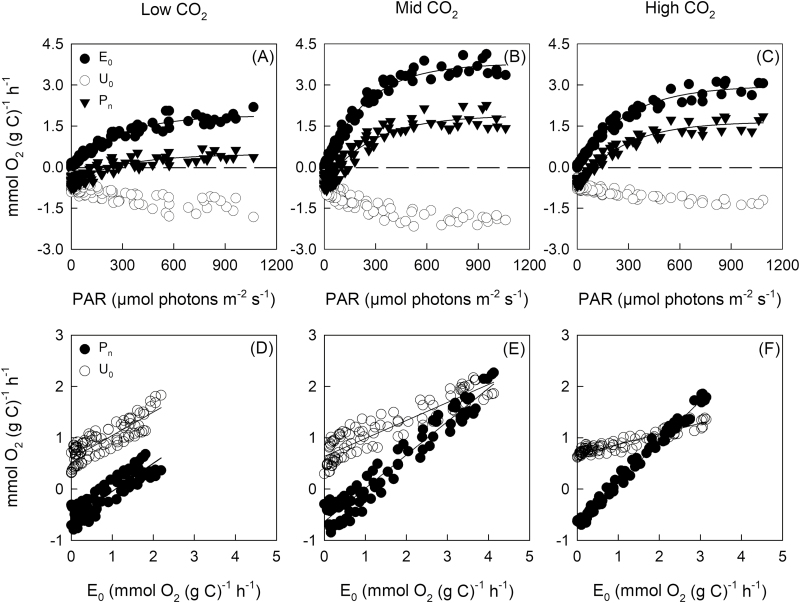
The C-specific light–response curves for gross O2 evolution, O2 consumption, and net photosynthesis (n=4) (A–C) and the relationship between gross net O2 evolution and net O2 evolution or O2 consumption (D–F) for T. erythraeum IMS101. Oxygen evolution rates are normalized to a carbon basis [mmol O2 (g C)–1 h–1]. The dashed line represents where gross O2 evolution equals O2 consumption (i.e. net photosynthesis=0). Note, Chl a- and N-specific light–response curves are reported in Supplementary Figs S2 and S3.